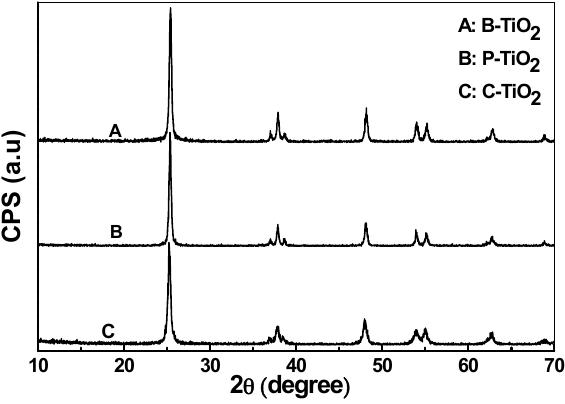
Figure 7. X-ray diffraction (XRD) patterns of the three TiO 2 hollow spheres.